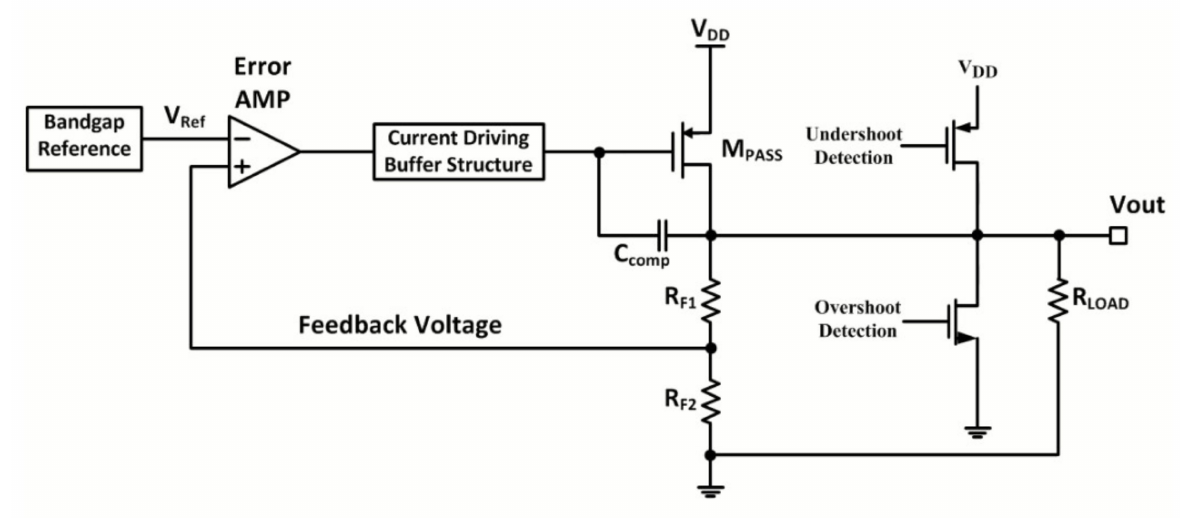
Figure 2. Proposed LDO